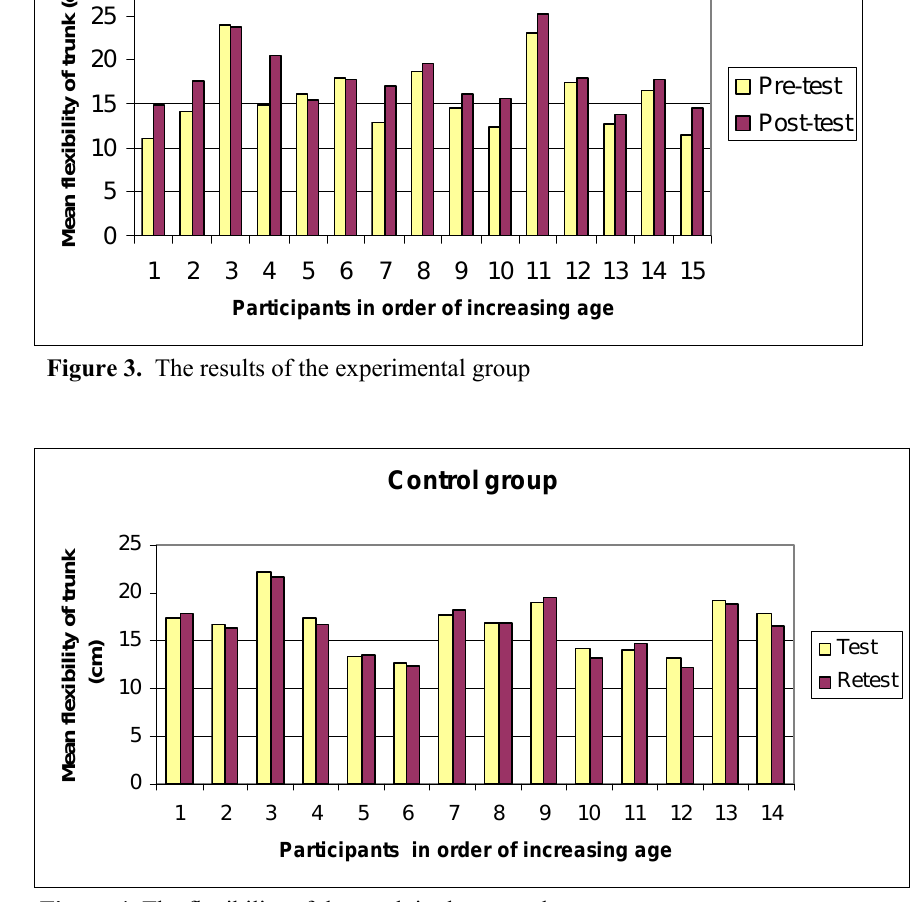
Figure 4. The flexibility of the trunk in the control